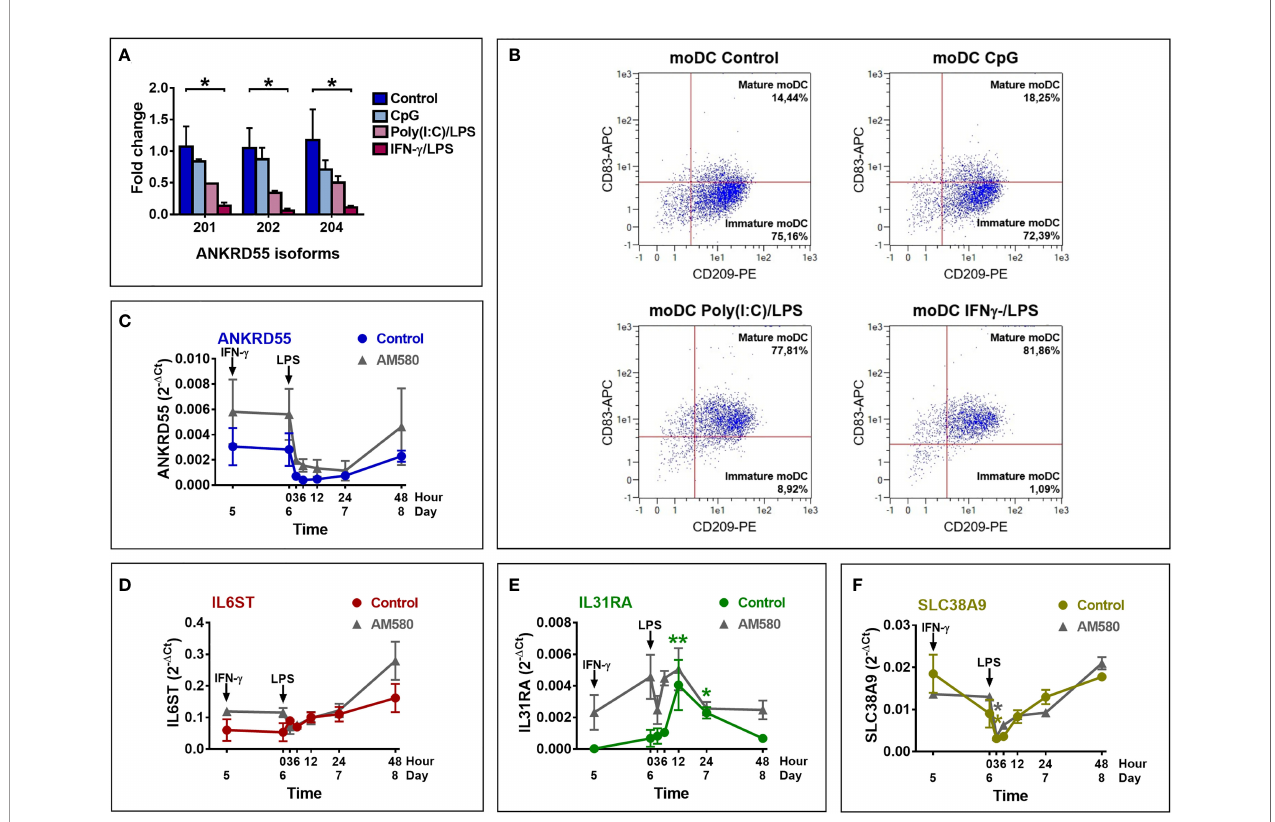
FIGURE 3 | Effect of maturation of moDC on the expression of ANKRD55 , IL6ST , IL31RA , and SLC38A9 . (A) Comparison of the effect of maturation by CpG, poly(I: C)/LPS and IFN- g /LPS on expression levels of the main ANKRD55 splice variants by qPCR. Mean ± SEM; n = 3; Friedman test (followed by Dunn ’ s multiple comparison test). (B) Flow cytometry to assess the maturation percentage induced by the indicated stimuli based on the expression of CD209 (expressed in moDC) and CD83 (expressed in mature moDC only). Shown is a representative experiment out of 4 performed. (C – F) MoDCs cultivated for 5 days in MoDC medium were matured by addition of IFN- g and 24 h later LPS. Gene expression was analyzed by qPCR coinciding with time of IFN- g (day 5) and LPS (0 h) addition and 3, 6, 12, 24, and 48 h later. The experiment was also performed in cells differentiated in the presence of AM-580 (gray curves). Mean ± SEM of 3 independent measurements; Friedman test (followed by Dunn ’ s multiple comparison test) for comparison of data points in each curve with day 5 and Wilcoxon test for comparison of both curves (control vs. AM580). * p ≤ 0.05, ** p ≤